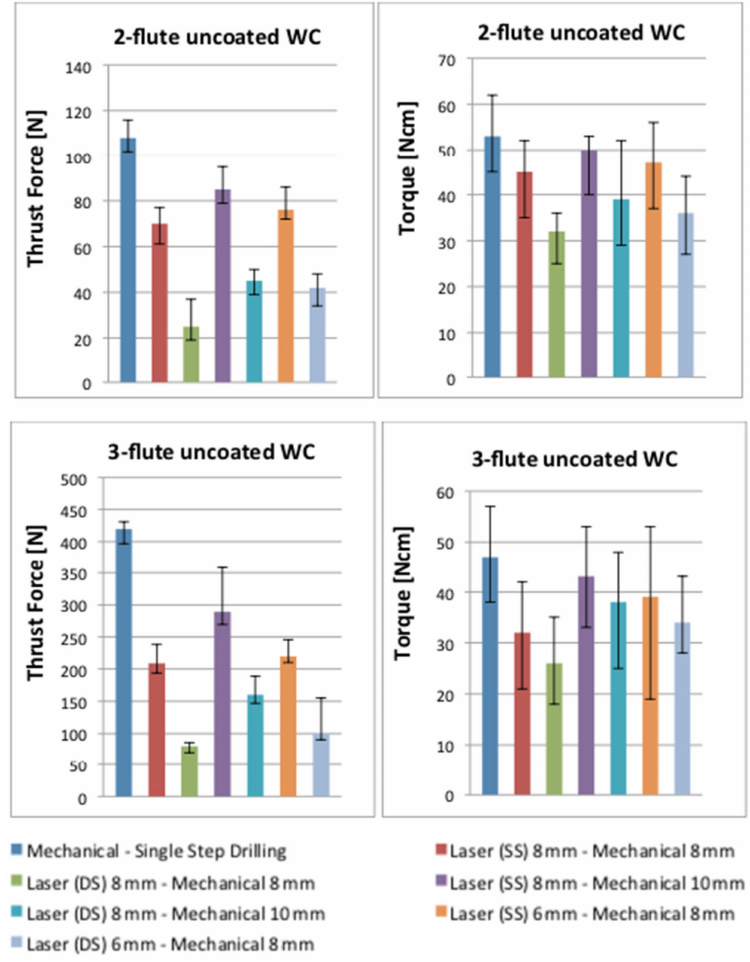
Figure 8. Thrust force and torque results from sequential